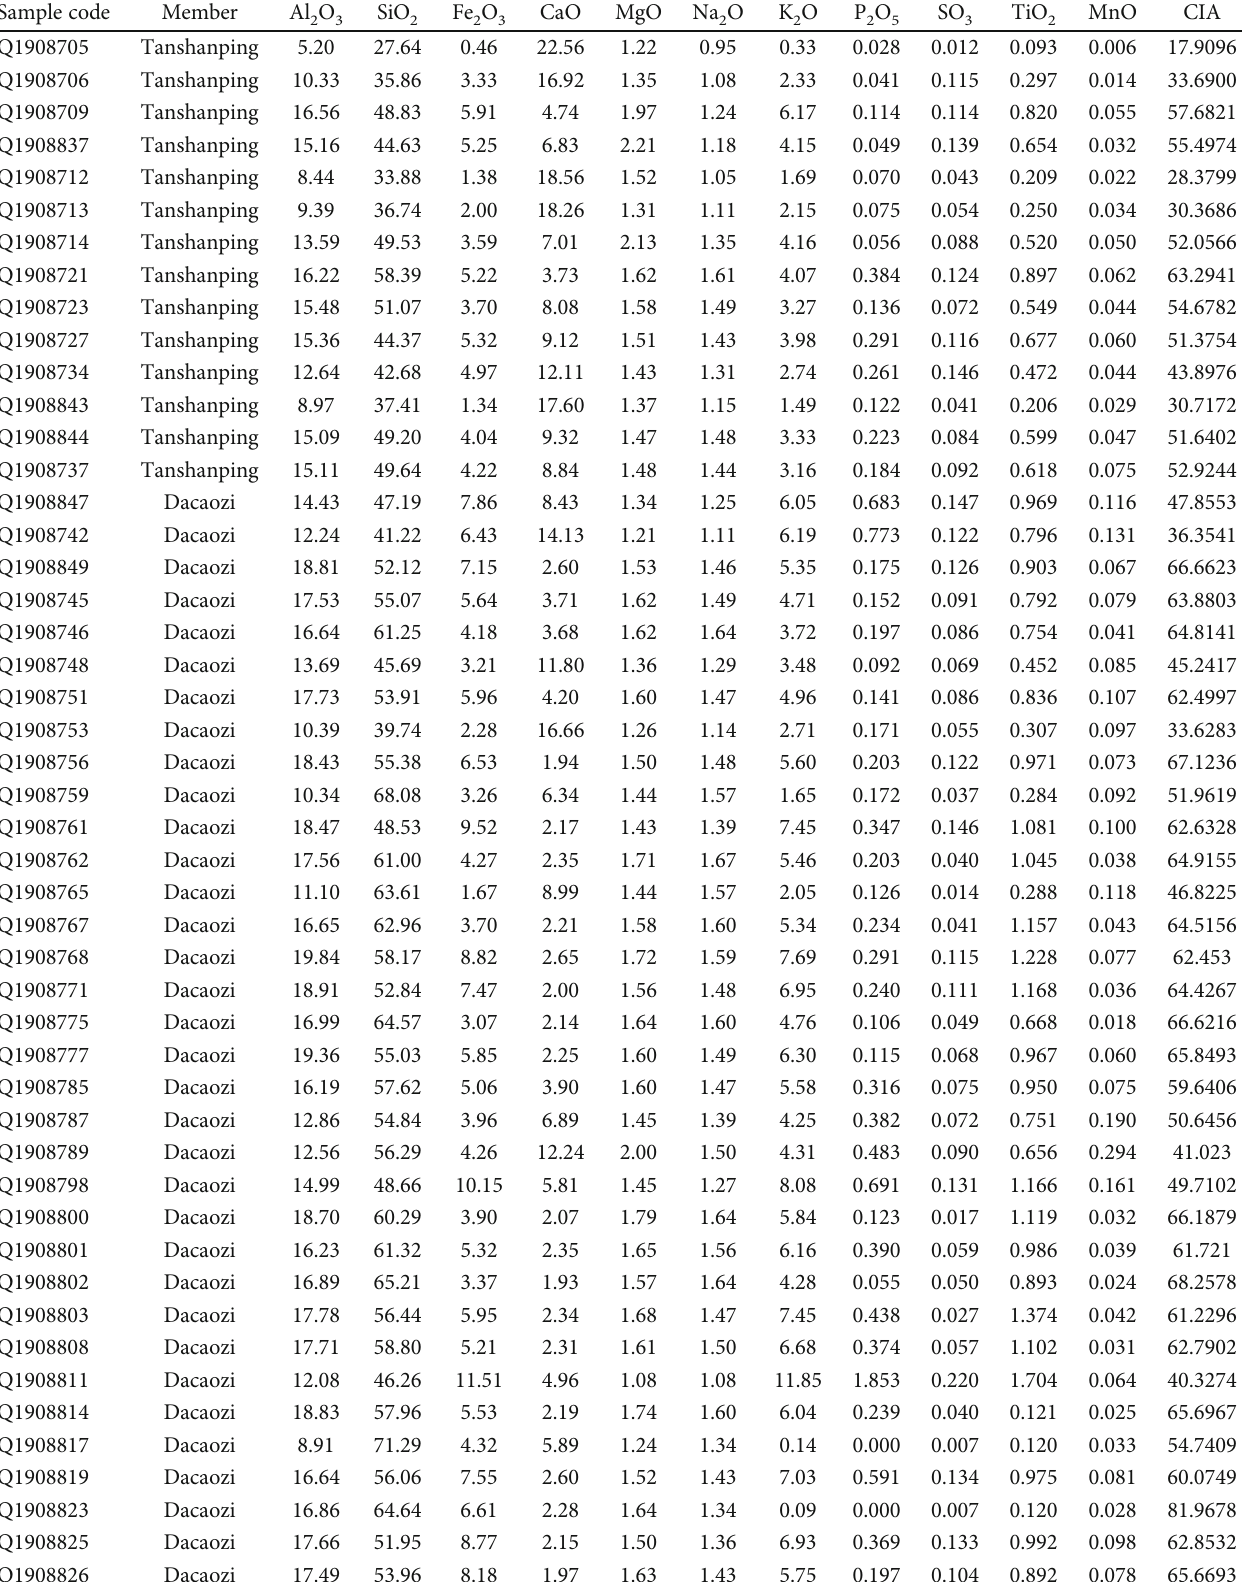
Table 1: Concentrations of major elements (unit: wt%) in samples from the Tanshanping and Dacaozi Formations in the Ninglang-Yanyuan